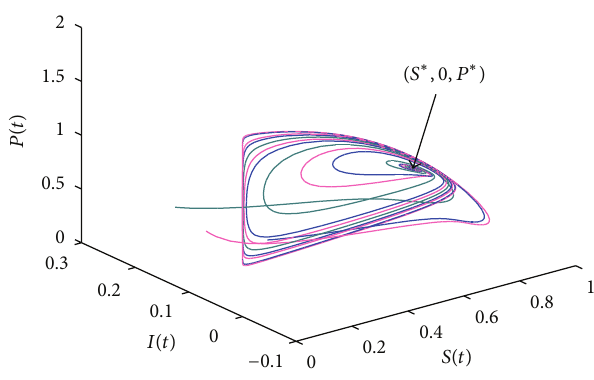
Figure 2: Phase portrait ( 𝑆 - 𝐼 - 𝑃 space) of model system (20) with = 1.0653 , and 𝑢 = 0.483 and differential initial values, 𝜎 𝛿 1𝛿 which indicates model system (20) is globally stable around 𝑀 ∗ (0.5648, 0, 0.9406, 0.0501) .